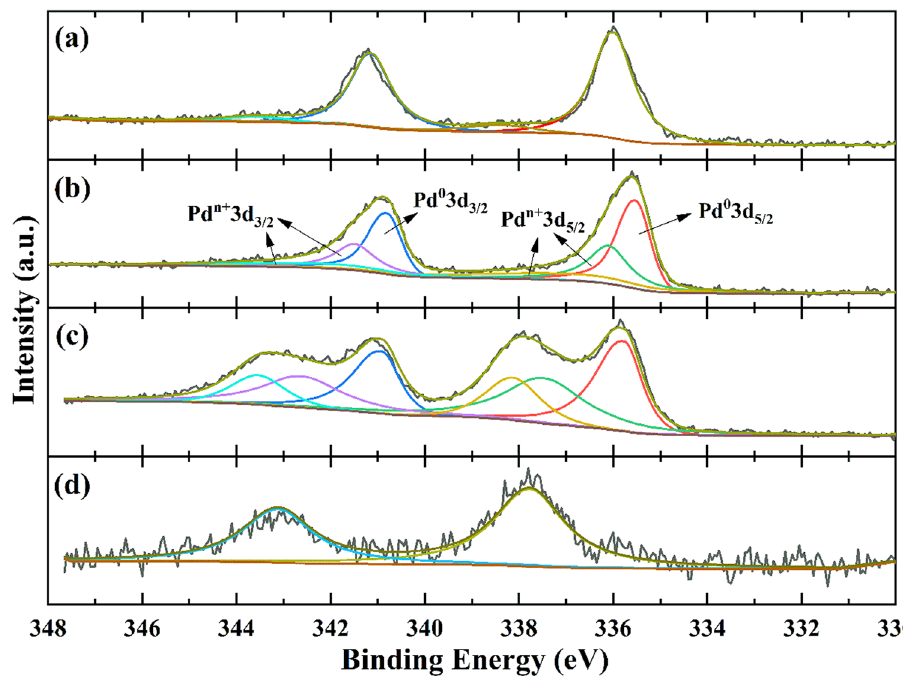
Figure 4: XPS spectra: reduction of 1.0 Pd/3DGNs at ( a ) 973 K, ( b ) 773 K, ( c ) 573 K, and ( d ) 523